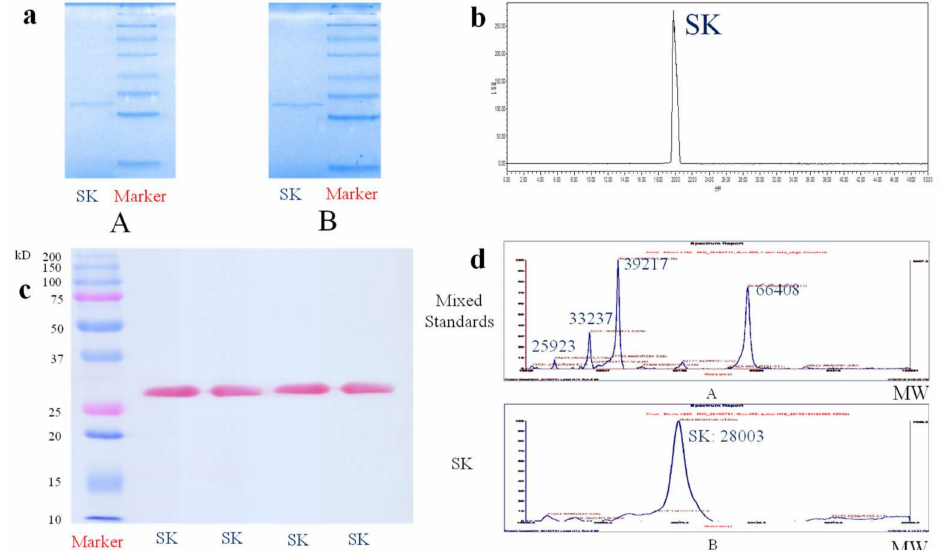
Figure 2. Purity identification of SK. ( a ) The Native–PAGE profile (A) and SDS-PAGE profile (B) of SK. ( b ) Gel filtration chromatogram of SK by UPLC analysis. ( c ) Electroblotting profile of SK. ( d ) The chromatogram of mixed standards with different molecule weight (A) and SK (B) by MALDI-TOF